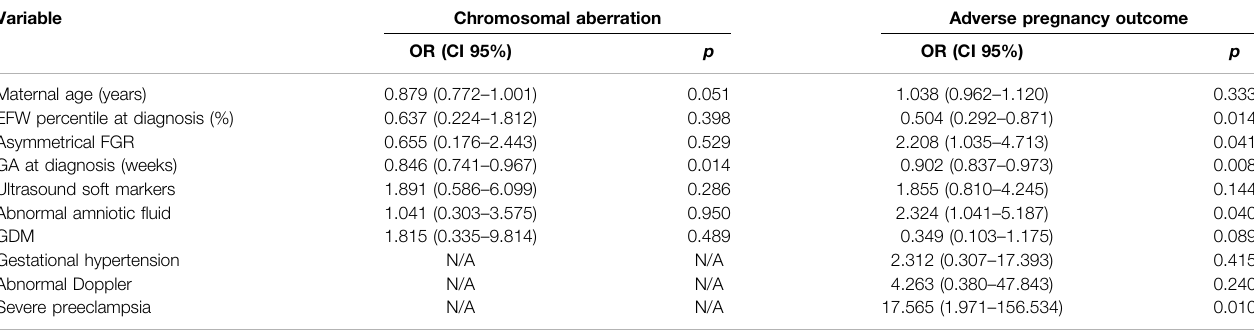
TABLE 3 | Logistics regression analysis in risk factors of adverse outcome in FGR.